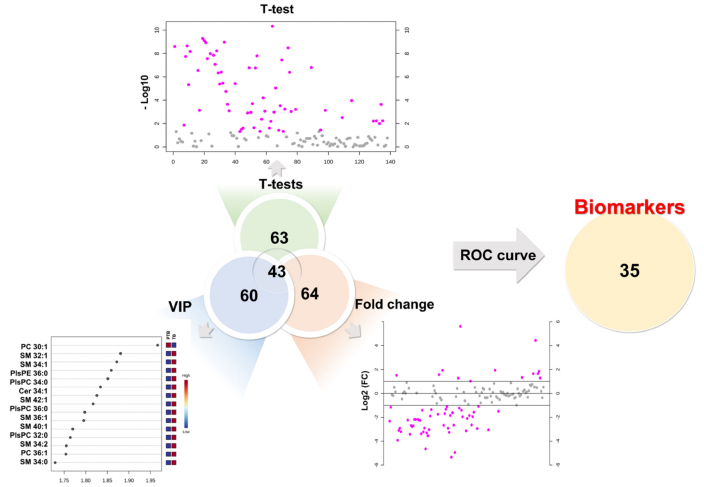
Figure 4. Development of biomarkers. First candidates had to simultaneously satisfy a p- value ( ≤ 0.05), foldchange ( ≥ 2 or ≤ 0.5), and VIP ( ≥ 1). Final biomarkers were applied area under the curve (AUC) of ROC curves ( ≥